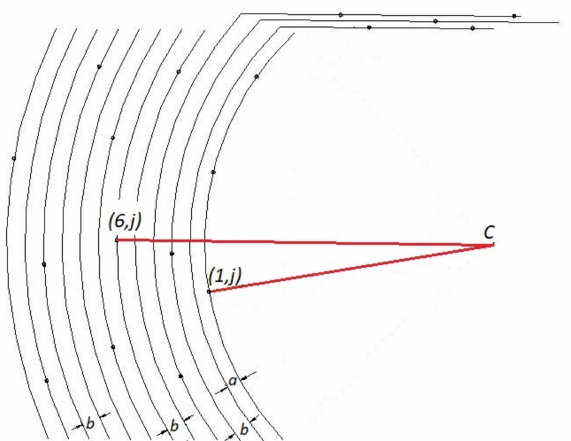
Figure A1. The computation scheme for the circular part of the sitting place ( koilon , cavea ) of the Makyneia theatre. The radius between the unknown center C of the circle and a point on a row (dots) defines an observation equation. The width a of the lowermost row of seats and b of the other rows are marked. Two representative radii are shown in red. Modified after